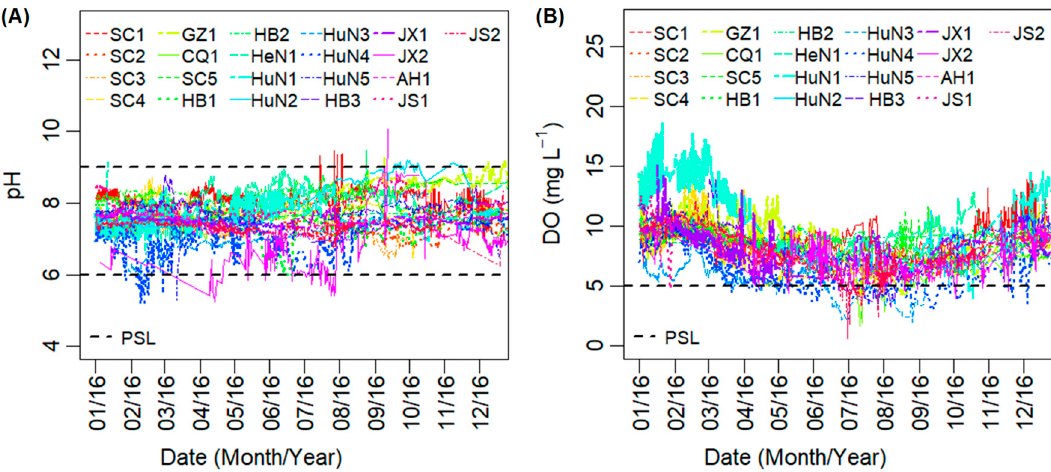
Figure 9. Real-time series for pH ( A ) and dissolved oxygen ( B ) at the 21 YRB sites in 2016.